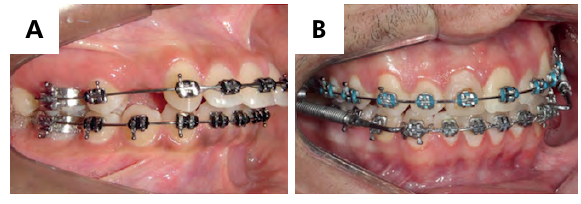
Figure 1. A. Intraoral lateral view of a patient from the extraction group. B. Intraoral lateral view of a patient from the Forsus group.